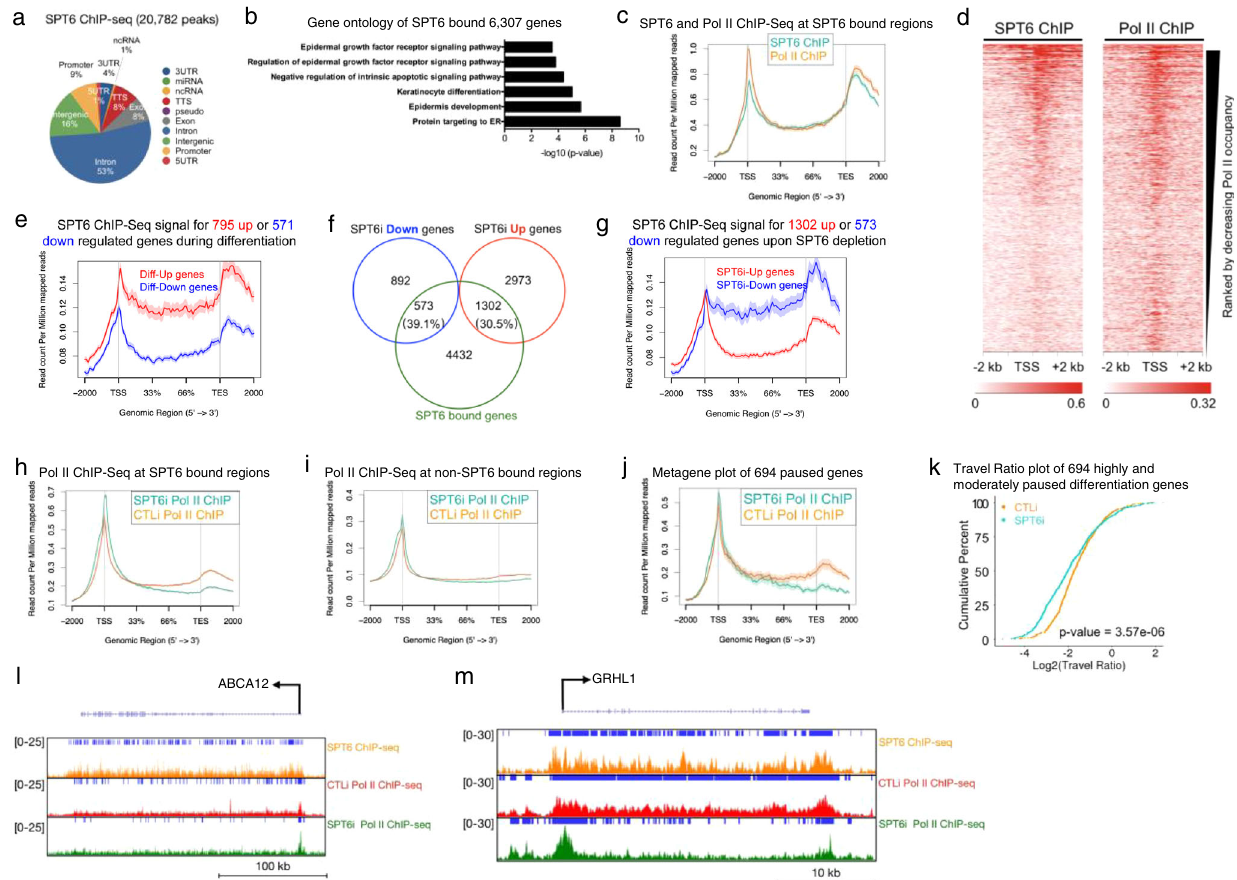
Fig. 3 SPT6 binds to epidermal differentiation genes and is necessary for their transcriptional elongation. a Genomic localization of the 20,782 SPT6 bound peaks. SPT6 ChIP-Seq was performed in replicates from day 3 differentiated keratinocytes. b Gene ontology terms of the 6307 genes that the 20,782 SPT6 bound peaks mapped back to. c Metagene plot of SPT6 (teal) and RNA Pol II (orange) ChIP-Seq reads at SPT6 bound regions. Y -axis is shown as read count per million reads and X -axis is distance along SPT6 bound genes. d Heatmap of SPT6 and Pol II ChIP-Seq ranked by decreasing Pol II occupancy. X -axis shows − 2 kb to + 2 kb from the TSS. e SPT6 ChIP-Seq signal for the 795 genes upregulated upon differentiation (Diff-Up) is shown in red. SPT6 ChIP-Seq signal for the 571 genes downregulated upon differentiation (Diff-Down) is shown in blue. Read count per million mapped reads is shown on the Y -axis. The X -axis represents regions across genes. TSS is transcription start site and TES is transcription end site. Average values are shown between experiments. f Venn diagram of SPT6 bound genes (SPT6 ChIP-Seq) with genes increased or decreased upon SPT6 depletion. g SPT6 ChIP-Seq signal for the 1302 genes upregulated upon SPT6 knockdown (SPT6i-Up genes) is shown in red. SPT6 ChIP-Seq signal for the 573 genes downregulated upon SPT6 loss (SPT6i-Down genes) is shown in blue. Read count per million mapped reads is shown on the Y -axis. The X -axis represents regions across genes. TSS is transcription start site and TES is transcription end site. Average values are shown between experiments. h Plot of CTLi (orange) and SPT6i (teal) Pol II ChIP-Seq at SPT6 bound regions. Y -axis is shown as read count per million reads and X -axis is distance along SPT6 bound genes. CTLi and SPT6i Pol II ChIP-Seq in differentiation conditions were performed in replicates. i Plot of CTLi (orange) and SPT6i (teal) Pol II ChIP-Seq at non-SPT6 bound regions. j Plot of CTLi (orange) and SPT6i (teal) Pol II ChIP-Seq at the 694 differentiation genes paused in proliferation conditions. k Travel ratio plot of the 694 differentiation genes paused in proliferation conditions. The average travel ratio of those genes in CTLi (orange) and SPT6i (teal) cells in differentiation conditions is shown. The Y -axis shows the cumulative percentage of genes and X -axis shows the travel ratio plotted in Log2. p value calculated using two- sided Fisher ’ s Exact test. Gene tracks of ABCA12 ( l ) and GRHL1 ( m ). SPT6 ChIP-Seq in differentiation conditions is shown in orange. CTLi (red) and SPT6i (green) Pol II ChIP-Seq in differentiation conditions are also shown. Y -axis shows reads per million and blue bar over gene tracks represent signi fi cant